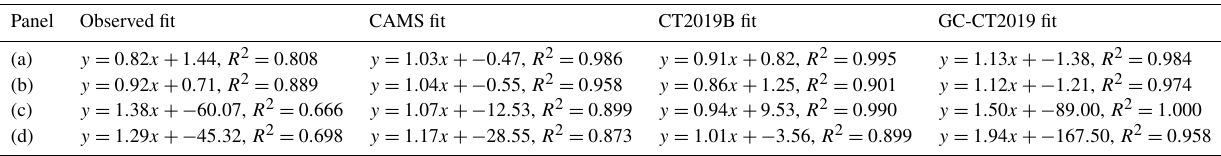
Table 3. Linear regression equations and correlation coefficients for the correlations in Fig. 3 in which SCA and HDD from NNG or model estimates near the ground sites are compared to SCA and HDD from spatially averaged satellite observations or spatially averaged model estimates over the corresponding 5 ◦ latitude by 10 ◦ longitude coincidence regions and encompassing 5 ◦ latitude by 20 ◦ longitude